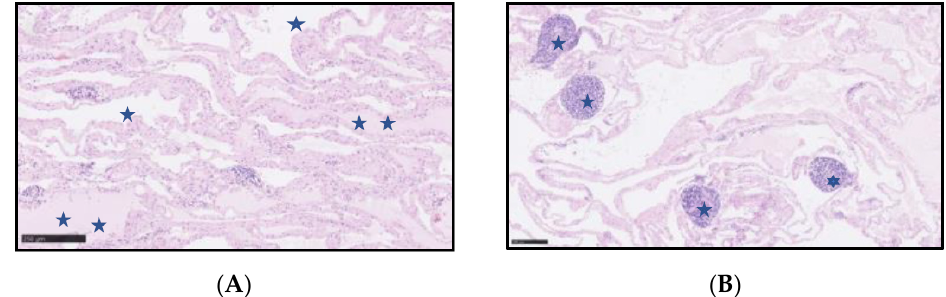
Figure 5. ( A ) Lymphangioma cavernosum—Vascular spaces (one blue star)*, some of them with a proteinaceous fluid (two blue stars). ( B ). Lymphangioma cavernosum—Small clusters of lymphocytes (one blue star) within the lymphangioma. Haematoxylin and eosin staining.